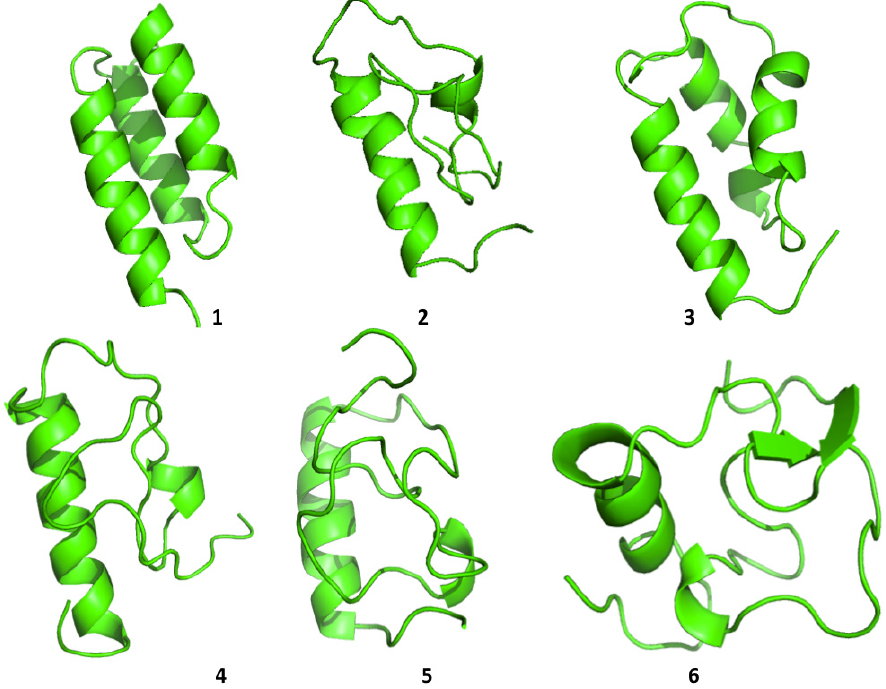
Figure 5. The representatives of the six most populated structural clusters for Protein